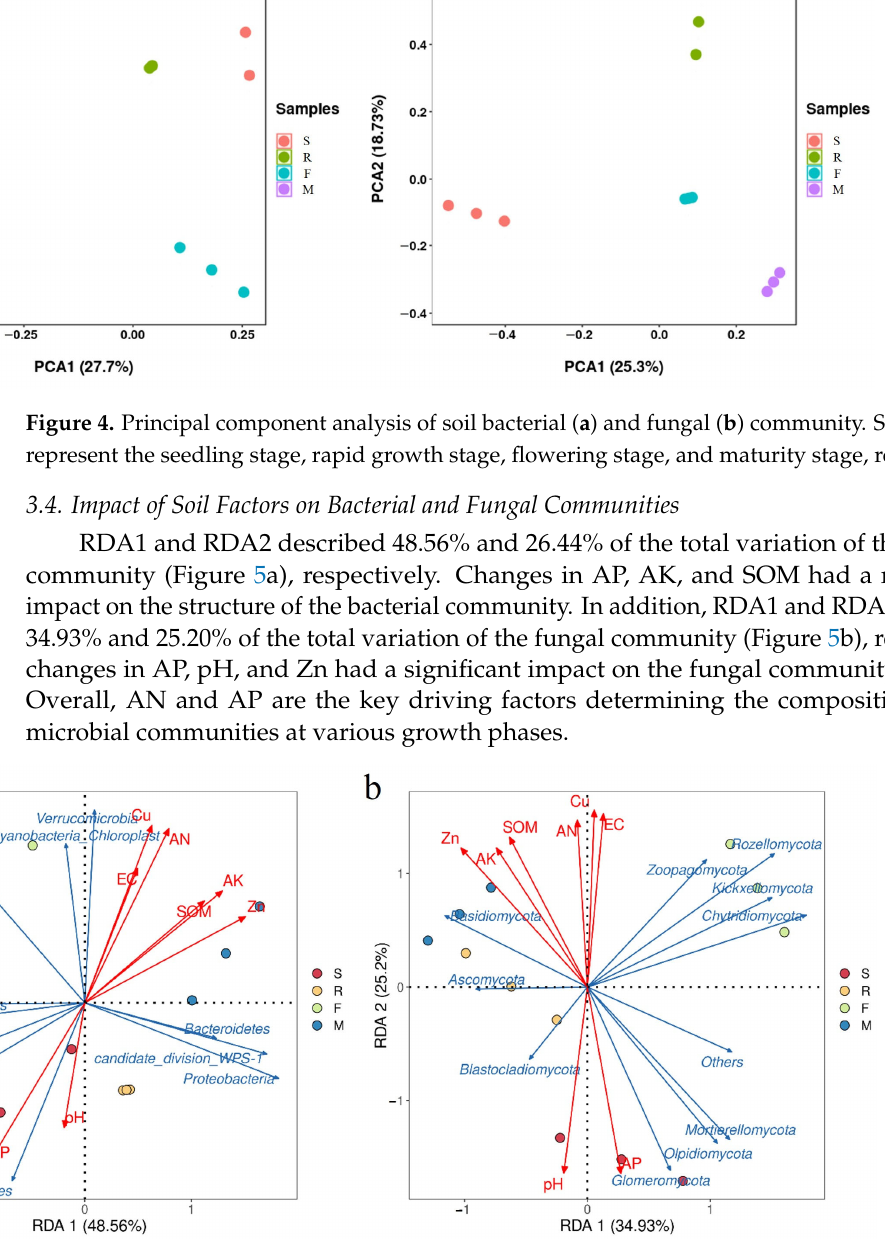
sphere soil at different growth stages (Figure 4). The first two components explained